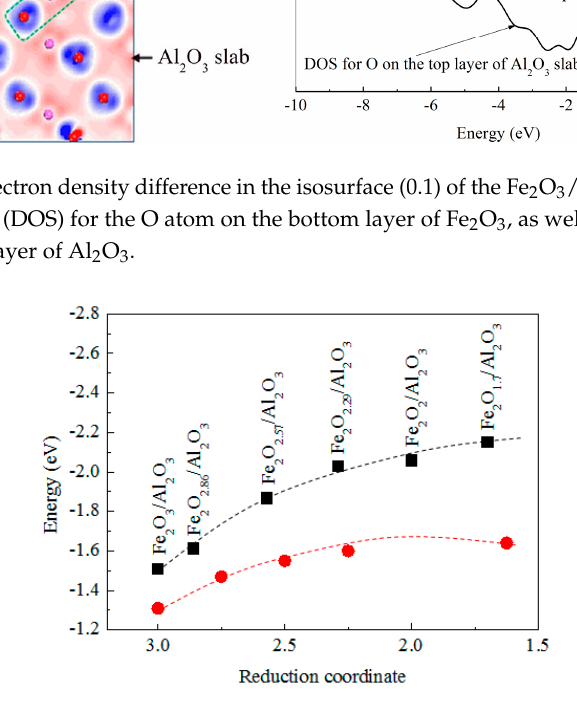
Reduction coordinate Figure 14. Energy required for removing O from the pure and reduced Fe 2 O 3 /Al 2 O 3 gradually into FeO/Al 2 O 3 , and Fe 2 O 3 (001) into FeO.